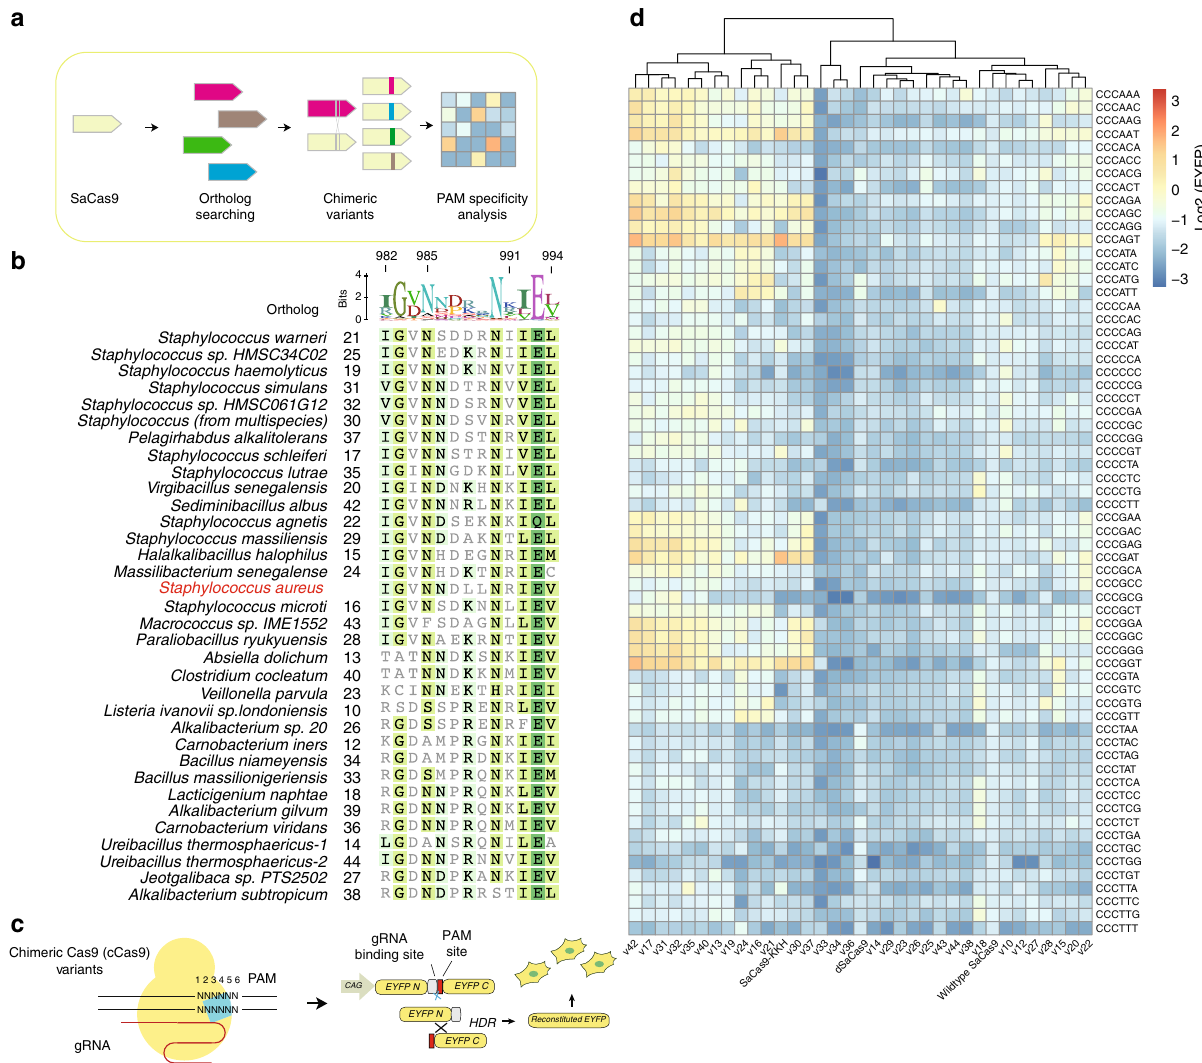
Fig. 1 Chimeric Cas9 with expanded PAM speci fi cities. a Design strategy for chimeric Cas9 (cCas9). b Sequence alignment of the 982 – 994 peptide fragment of orthologs. c Schematic of the EYFP reconstitution assay that was used to evaluate the cleavage activity of cCas9 variants at target sites containing indicated PAM sequences. d Data are shown as relative fl uorescence intensity of EYFP measured by using fl ow cytometer 3 days after transfection into HEK293FT cells ( n = 1). Source data are provided as a Source Data fi